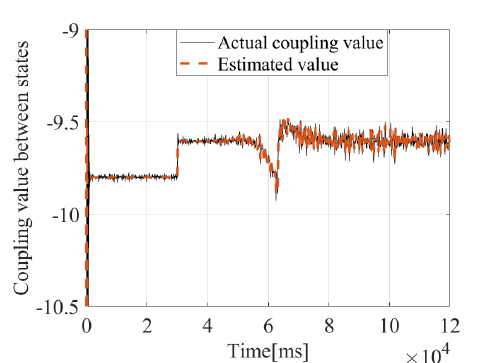
Fig. 13. Coupling estimation curve between states of pitch angle control